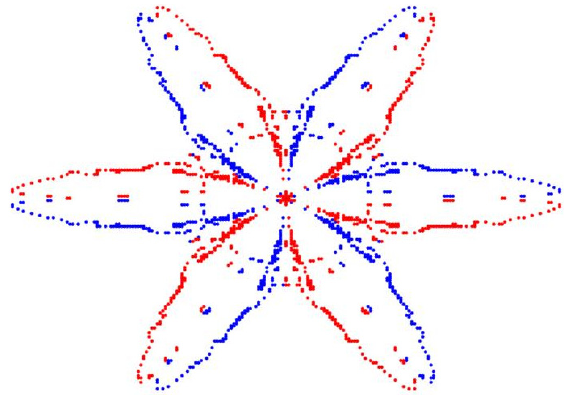
Figure 21. A poor connection on a PV module .